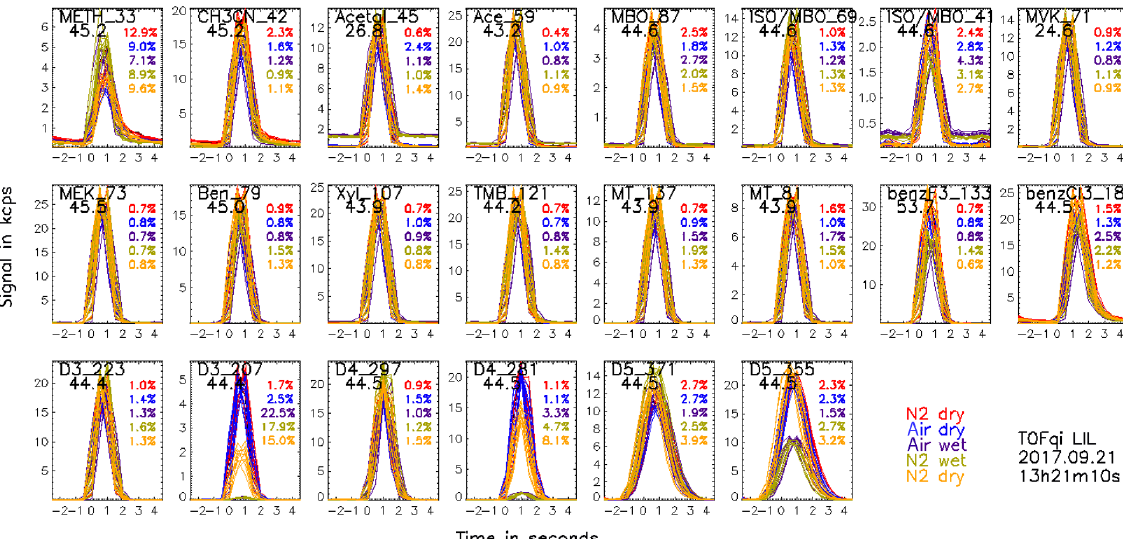
Figure 2. Raw count signal of the main ions produced by the organic compounds in the gas standard during the 50 sample loop injections. For example, the top right chart shows the signal at 71.049Th originating from protonated methyl vinyl ketone (MVK, C 4 H 6 O). In the top left of the chart an identifier code (including the integer m/Q value of the detected ion) is printed in black and the number below the identifier indicates the maximum volume mixing ratio (in nmolmol − 1 ) that is expected during an injection. The different colours correspond to the injections in different carrier gases (with dry nitrogen, dry air, humidified air, humidified nitrogen, and dry nitrogen corresponding to red blue purple green, and yellow, respectively). The percent values printed at the right edge of each chart indicate the reproducibility of the 10 injections of each